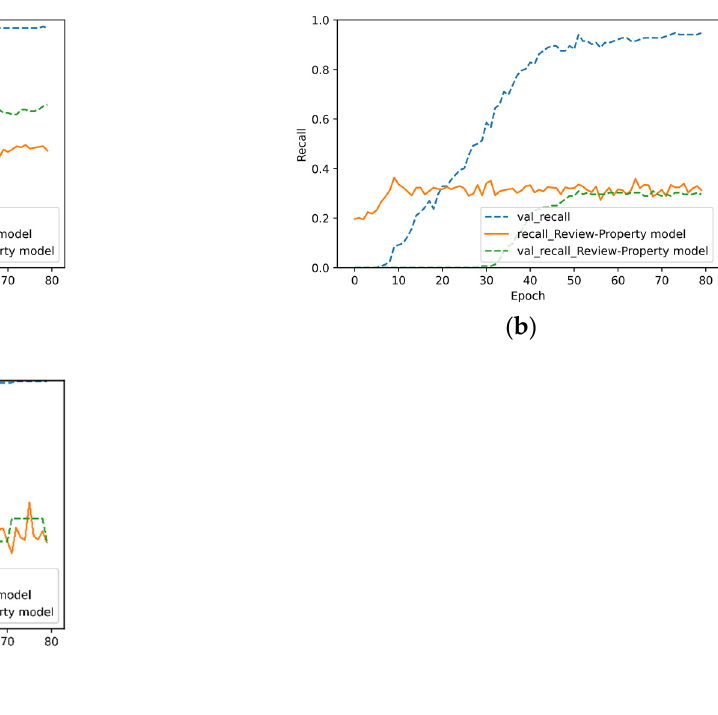
Figure 9. Experimental results of the review–property model: ( a ) accuracy, ( b ) recall, and ( c ) F 1 score.